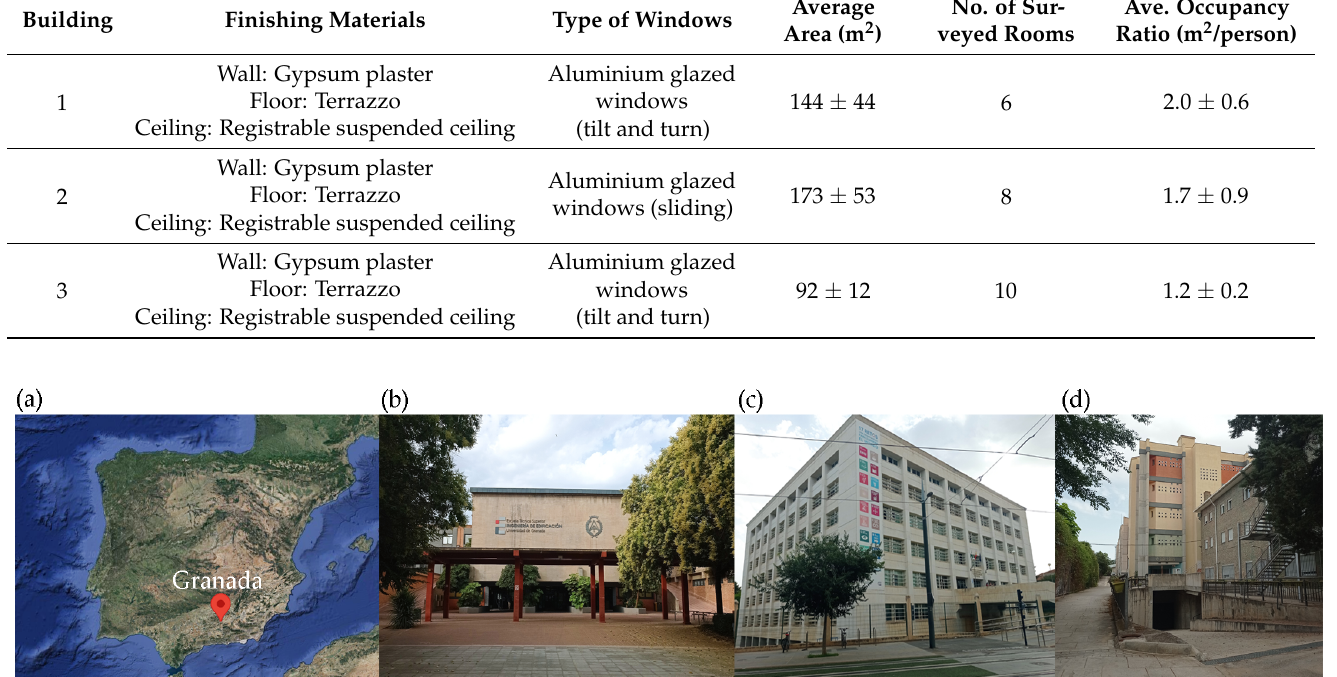
Table 2. Characteristics of the sensors used in the field measurement campaign.